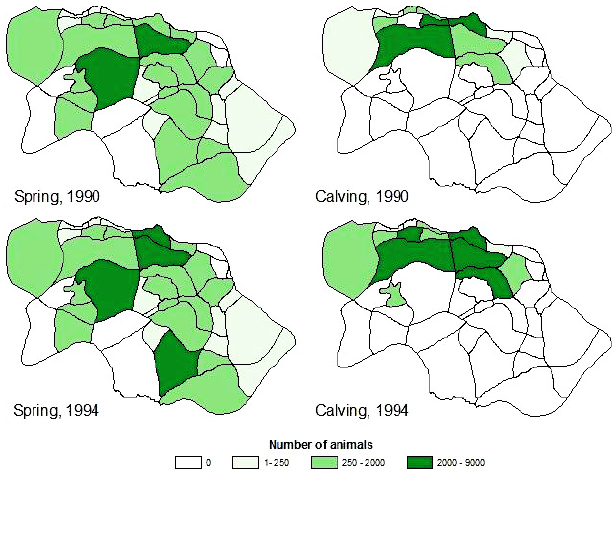
Fig. 2 . Illustration of model simulations for two adjacent seasons in 1990 and 1994. Snowmelt was early in both years; however, in 1994, more caribou started far south in zone 8 during spring migration, resulting in higher calving densities in zones 3 and 5 to the east of the coastal